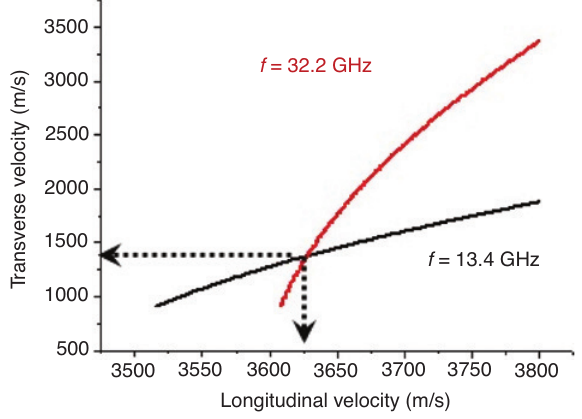
, v ) couple of velocity Figure 22: The black curve represents the ( v t l which reproduce the fundamental mode at 13.4GHz and the red curve the similar ( v , v ) couple associated to the second feature t l at 32.2 GHz. The crossing point give a self-consistent elastic characterization for a single